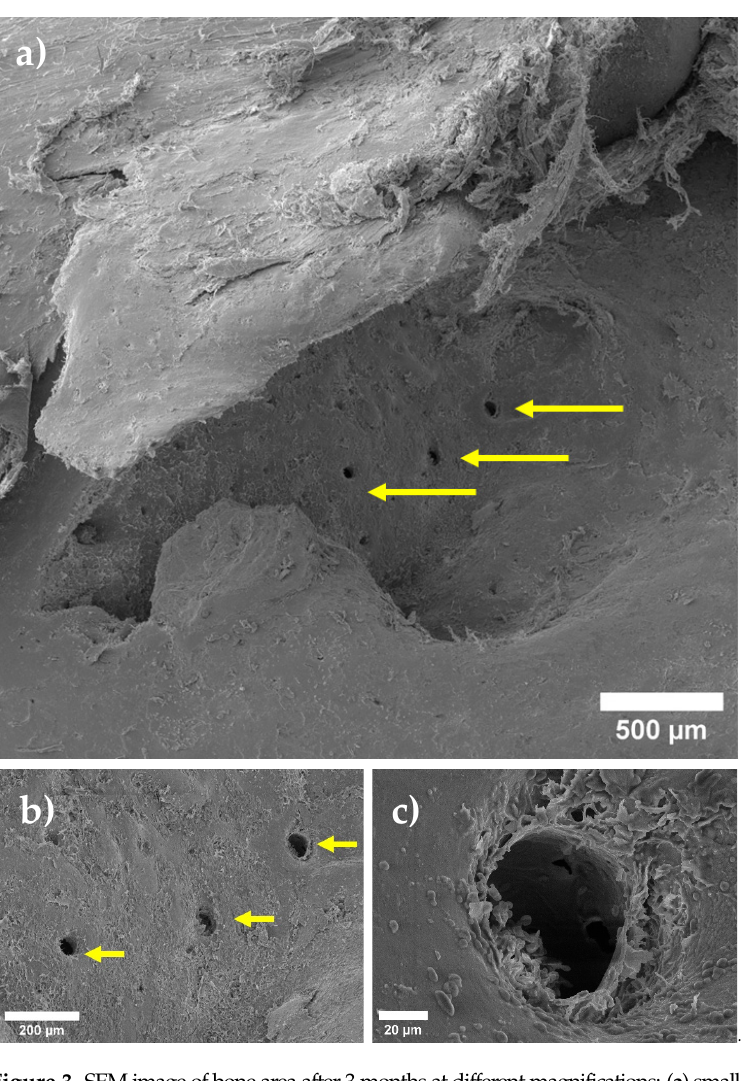
Figure 3. SEM image of bone area after 3 months at different magnifications: ( a ) small, ( b ) medium, and ( c ) large, respectively. Arrows in picture show pores associated with release of hydrogen during biodegradation of magnesium alloy.